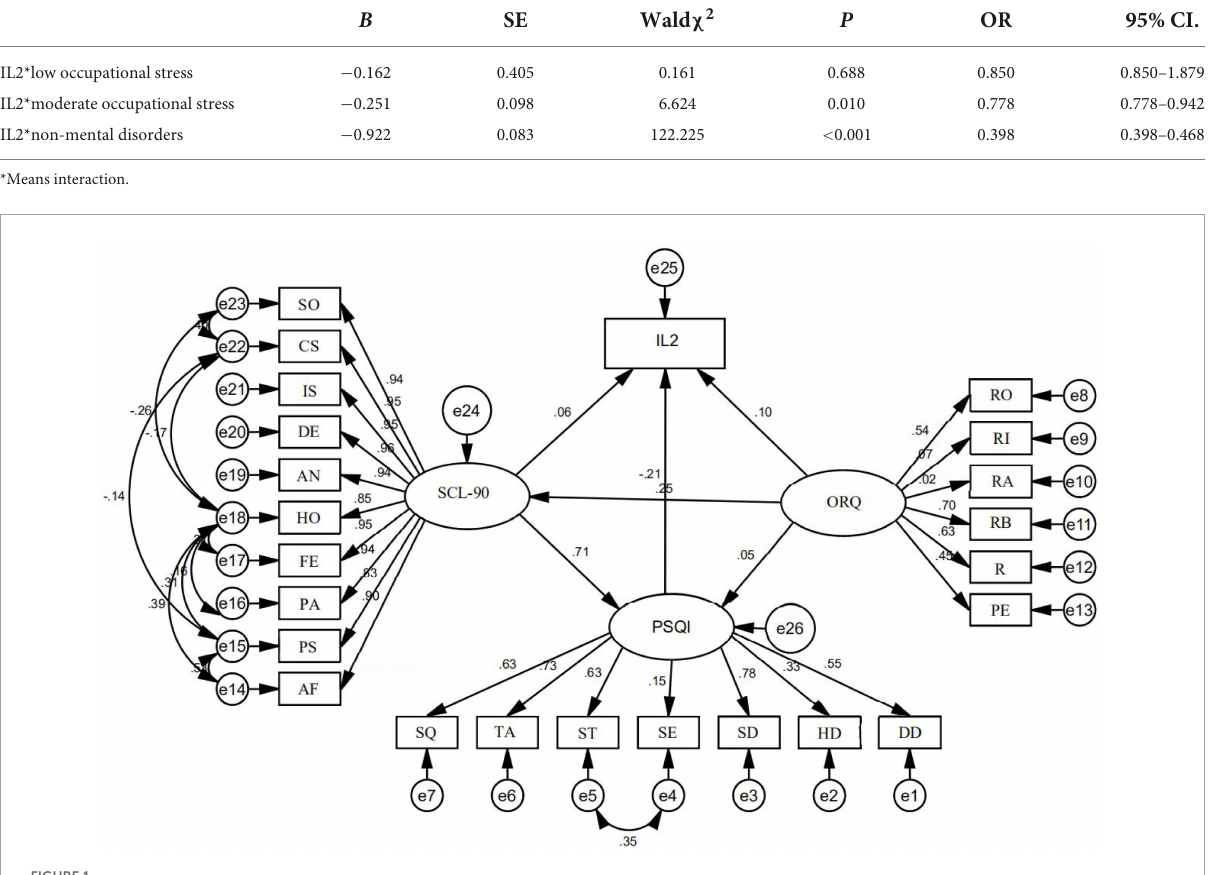
FIGURE1 Occupational stress–mental health–cytokine–sleep pathway analysis. IL2, interleukin-2; SCL-90, mental health; ORQ, occupational stress; PSQI, sleep quality; SO, somatization; CS, compulsive symptoms; IS, interpersonal sensitivity; DE, depression; AN, anxiety; HO, hostility; FE, fear; PA, paranoia; PS, psychosis; AF, another factor; SQ, subjective sleep quality; TA, time of falling asleep; ST, sleeping time; SE, sleep efficiency; SD, sleep disorders; HD, hypnotic drugs; DD, daytime dysfunction; RO, role overload; RI, role insufficiency; RA, role ambiguity; RB, role boundary; R, responsibility; PE, physical